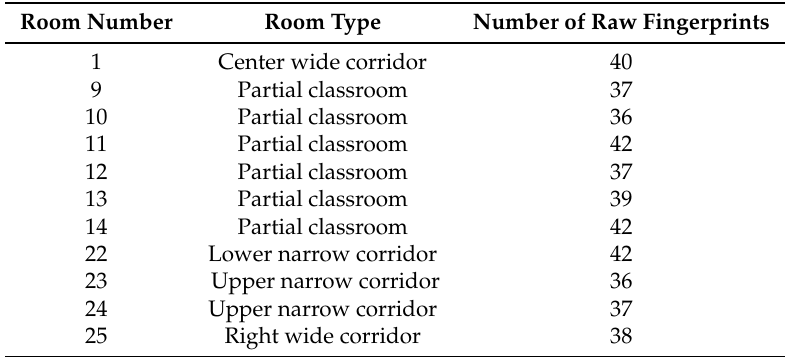
Table 1. Type and number of magnetic field fingerprints for each selected